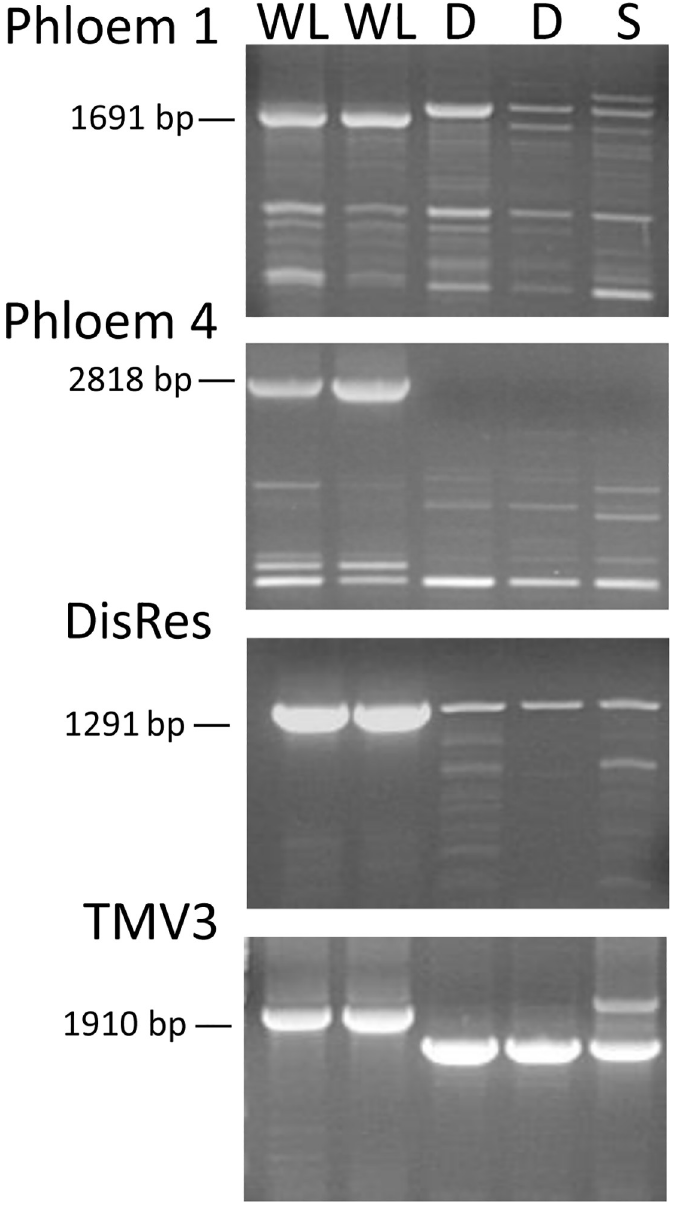
Fig 5. NLR -specific markers tightly linked to the Ry sto gene as detected on agarose gel. WL, ‘White Lady’; D, ‘De´sire´e’; S, ‘S440’. Two different isolates of D and WL genomic DNA were tested. PCR fragments were generated from genomic DNA with the primer pairs presented in Table